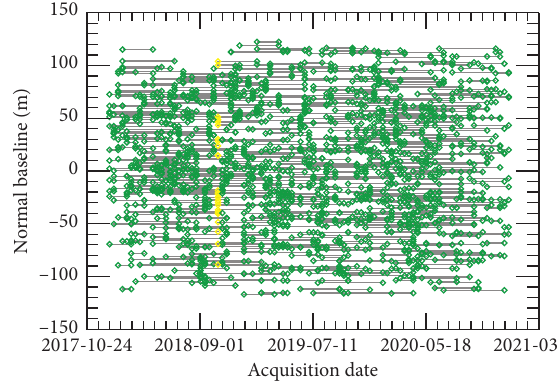
Figure 5: Interferometric image pairs of the